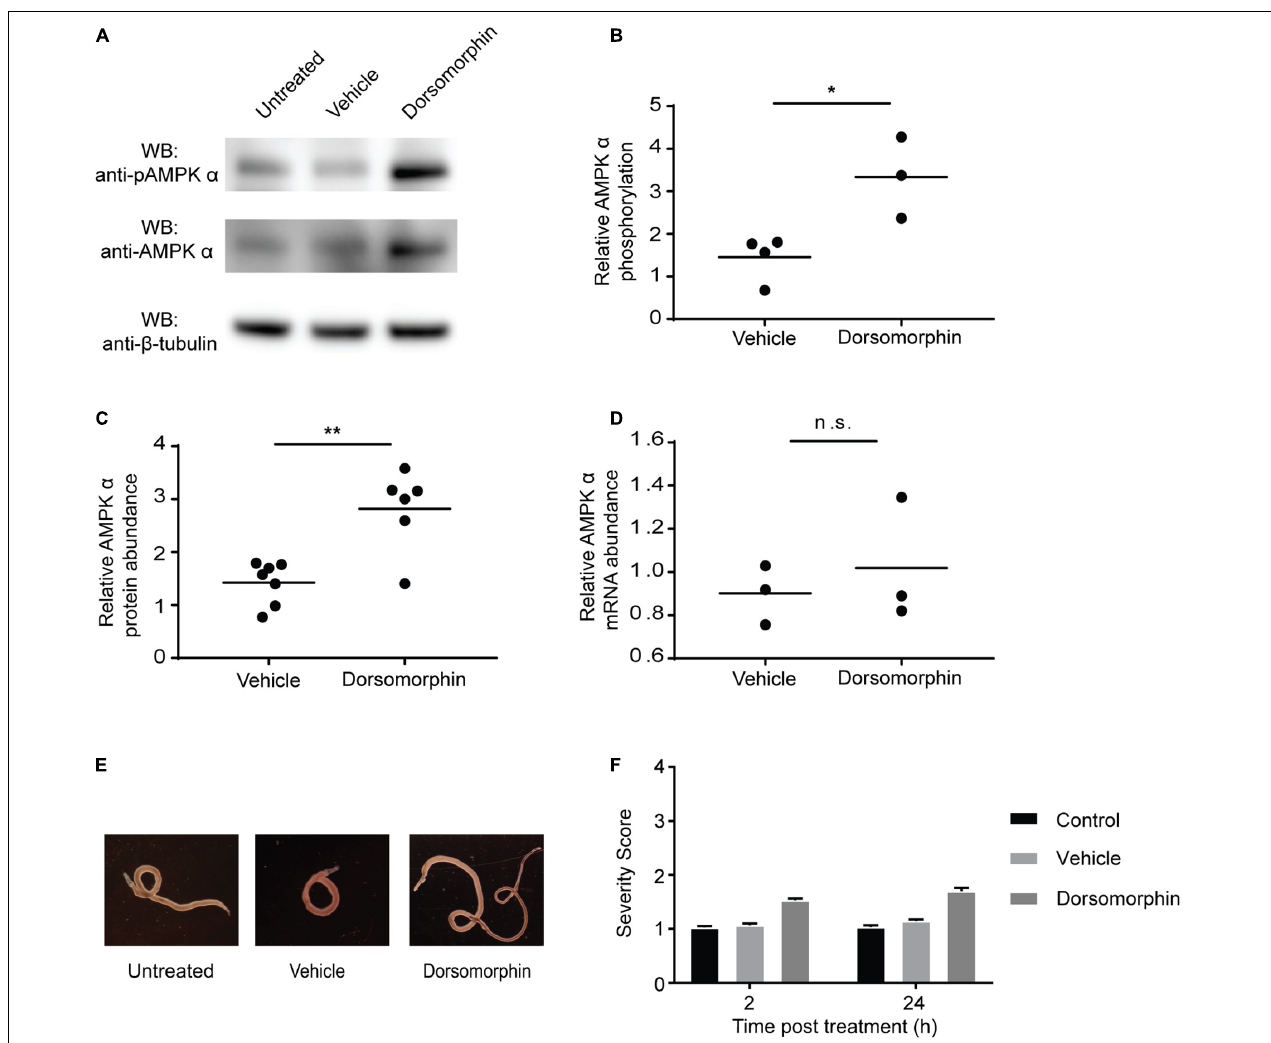
FIGURE 3 | Chemical inhibition of AMPK induces compensatory increases in AMPK α protein and phosphorylation. (A) Freshly isolated adult schistosomes were incubated in either media alone (untreated) or media supplemented with 10 µ M dorsomorphin or vehicle. After 24 h, lysates were prepared and equal amounts of protein were probed by Western blot using anti-pAMPK α antibody (top panel) , anti-AMPK α antibody (center panel) , and anti- β -tubulin antibody (bottom panel) . WB indicates the antibodies used for Western blotting. (B) Relative AMPK α phosphorylation under each condition was calculated by determining the ratio of anti-pAMPK α signal intensity to that of the anti-AMPK α signal intensity, and then normalizing to the intensity of the anti- β -tubulin signal to control for protein loading. Vehicle and dorsomorphin values shown are relative to untreated ratios (which were normalized to a value of 1). (C) Relative AMPK α protein abundance under each condition was calculated by determining the ratio of the intensity of the anti-AMPK α signal to that of anti- β -tubulin. Vehicle and dorsomorphin values shown are relative to untreated. (D) AMPK α transcripts of adult schistosomes exposed to the described conditions were quantified using quantitative real-time RT-PCR. AMPK α transcript abundance in vehicle and dorsomorphin samples relative to that of untreated samples are shown. Data points shown are biological replicates. (E) Freshly isolated adult schistosome pairs photographed after 24 h incubation in either medium alone (untreated) or medium supplemented with 10 µ M dorsomorphin or vehicle. (F) Worms incubated in either medium alone (control) or medium supplemented with 10 µ M dorsomorphin or vehicle were phenotypically scored after 2 and 24 h incubation in the aforementioned conditions. Data shown are averages of at least 3 biological replicates. ns P > 0.05, * P ≤ 0.05, ** P ≤